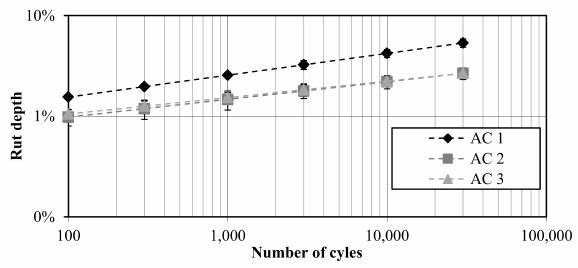
Figure 7: Rut depth results